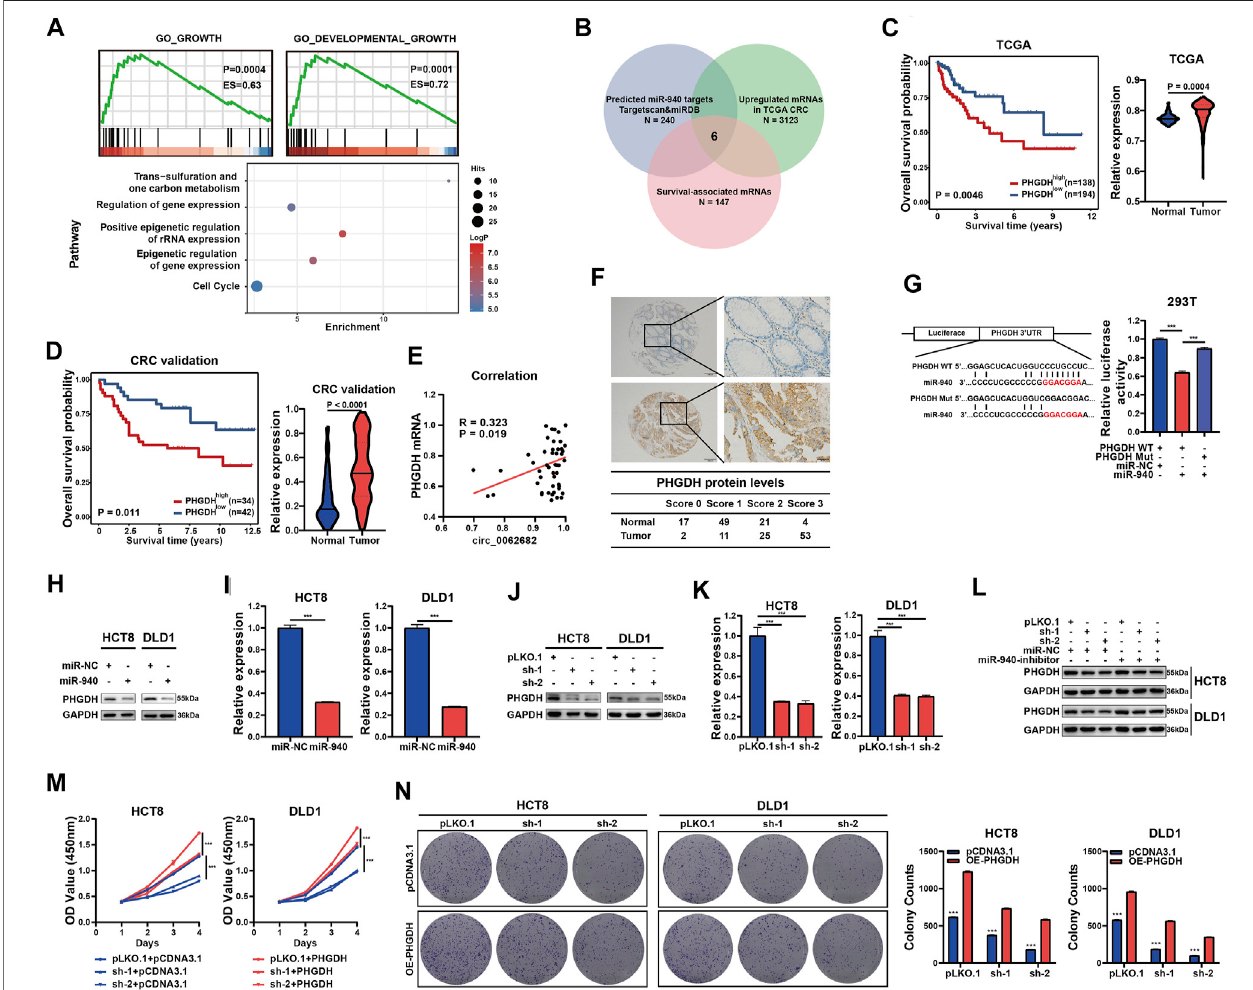
FIGURE 4 | Circ_0062682 upregulates the expression of PHGDH in CRC cells by sponging miR-940. (A) Predicted miR-940 target genes were enriched in one carbon metabolism, growth and development-related pathways using GSEA, GO and KEGG enrichment analyses. (B) Venn diagram showing the screening results of potential target mRNAs of miR-940. (C,D) The signi fi cantly upregulated mRNA expression of PHGDH in CRC tissues compared with normal tissues, which correlated with poor prognosis based on the TCGA CRC dataset (C) and an independent validation CRC cohort (D) . (E) A positive correlation between circ_0062682 and PHGDH expression in CRC tissues. (F) The protein expression of PHGDH in CRC tissues and NCTs was detected by immunohistochemistry staining. (G) The relative luciferaseactivitiesofPHGDH-WTorPHGDH-MutaftercotransfectionwithmiR-940mimic weredetermined bydualluciferasereporterassays. (H,I) Therelativeprotein (H) and mRNA expression levels (I) of PHGDH were determined by qRT-PCR and western blotting in miR-940-transfected CRC cells, respectively. (J,K) The relative protein (J) and mRNA (K) expression levels of PHGDH were determined in circ_0062682-silenced CRC cells by qRT-PCR and western blotting, respectively. (L) MiR- 940 inhibitor rescued the decreased protein expression of PHGDH induced by circ_0062682 knockdown in CRC cells. (M,N) PHGDH overexpression rescued the decreased activities of cell proliferation (M) and colony formation (N) induced by circ_0062682 knockdown in CRC cells. * p < 0.05; ** p < 0.001; *** p < 0.001.